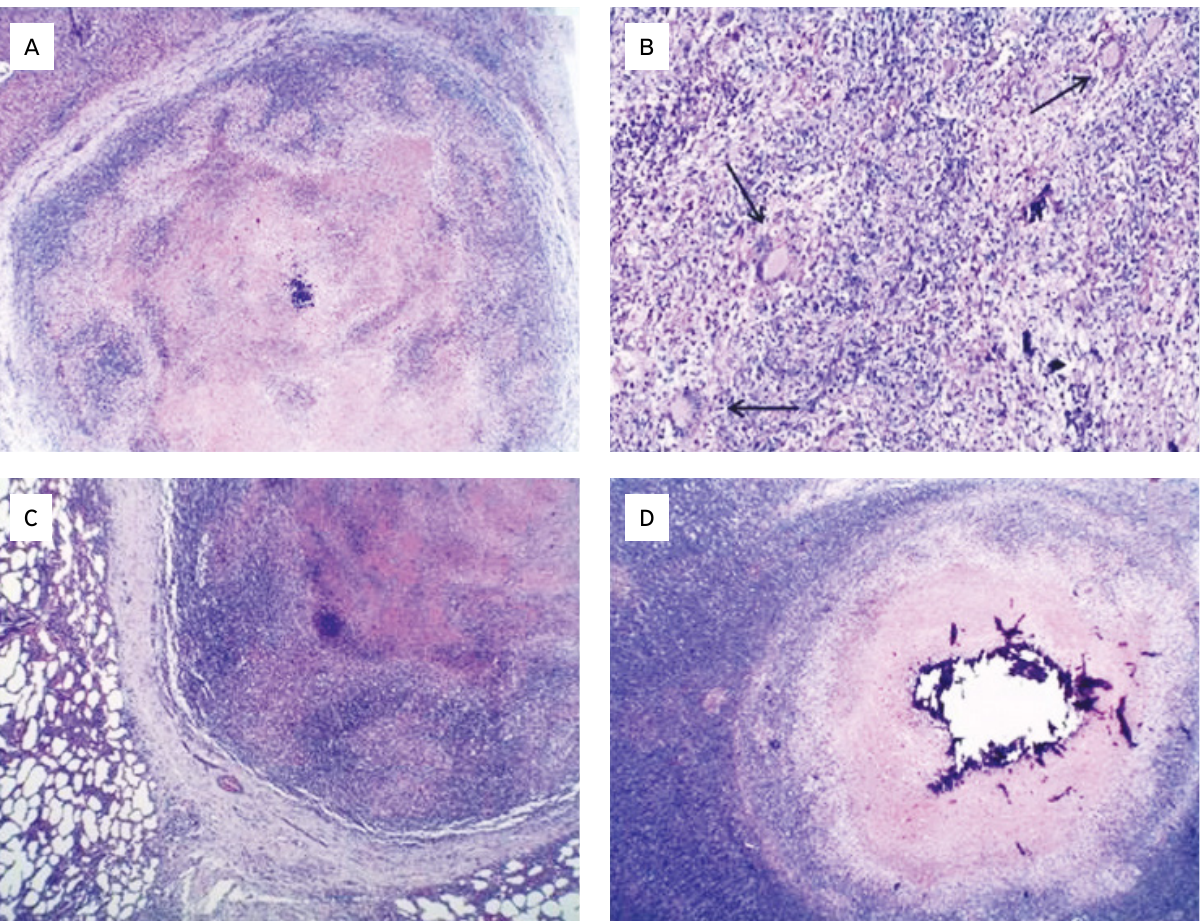
Figura 2. Fotomicrografia de amostras de fígado, pulmão e linfonodo mediastínico de bovinos positivos no teste cervical comparativo obtidas em abate sanitário para tuberculose bovina. São Gotardo, MG, 2012. (A) Secção de fígado. Granuloma envolvido por tecido conjuntivo fibroso, com área central de necrose caseosa com foco de calcificação. Hematoxilina‑eosina (HE). 5x (B) Parênquima hepático, as setas indicam células gigantes do tipo Langhans. Citoplasma amplo e núcleos dispostos na periferia da célula em forma de ferradura. HE. 40x. (C) Secção de pulmão. Granuloma tuberculoso circundado por espessa cápsula fibrosa. Necrose caseosa central com infiltrado de células monoclueares. HE. 5x. (D) Secção de linfonodo evidenciando estrutura granulomatosa com área de necrose central e calcificação distrófica HE.